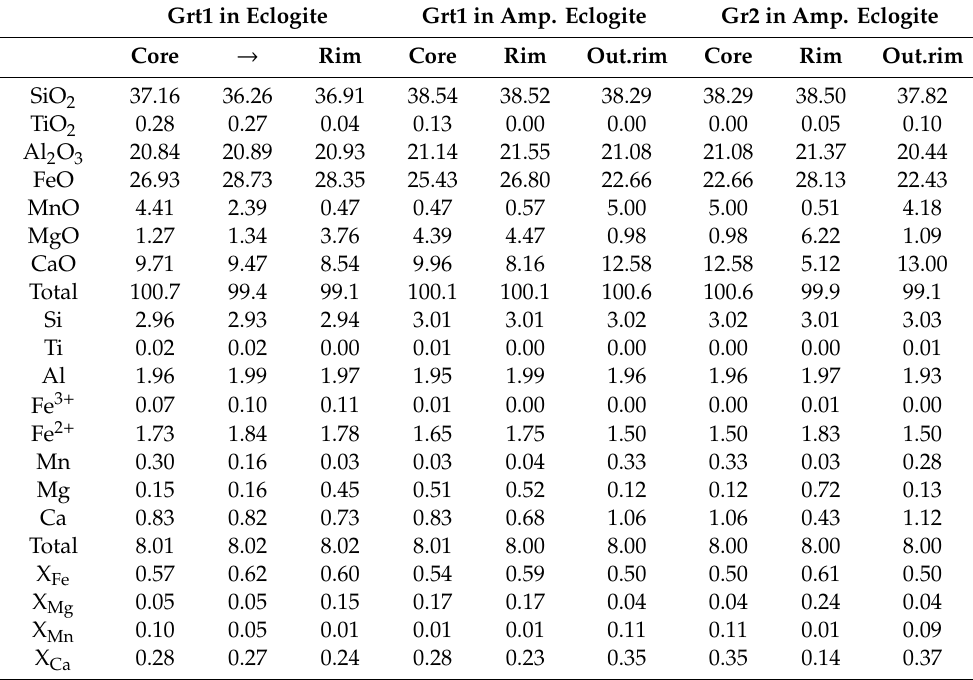
Table 1. Chemical compositions of garnets from the eclogites and amphibolitized eclogite. Grt1 in Eclogite Grt1 in Amp. Eclogite Gr2 in Amp. Eclogite Core → Rim Core Rim Out.rim Core Rim Out.rim